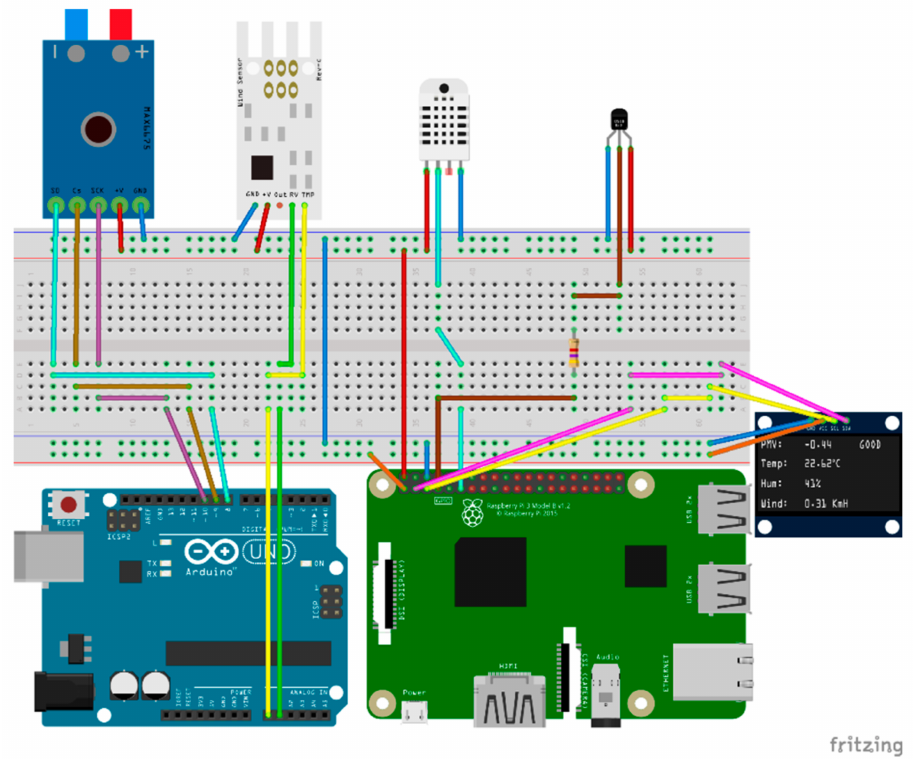
Figure 5. Breadboard view of the proposed hardware